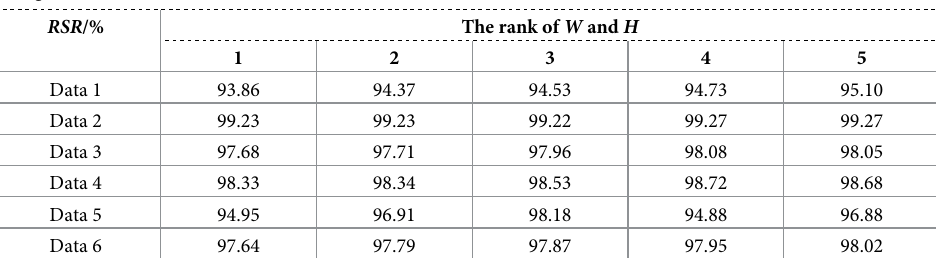
Table 5. Calculated reconstruction rate of multiple groups of different sEMG signals under different rank values using NMF